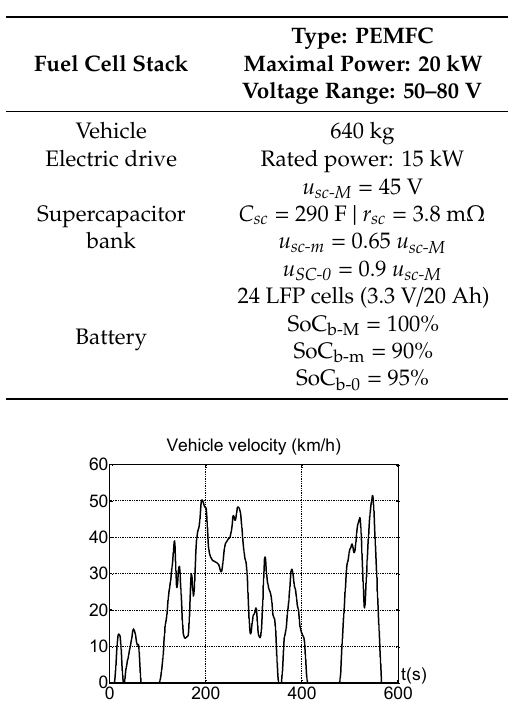
Figure 9. Standard driving cycle worldwide harmonized light-duty vehicles test cycle (WLTC) class 2 low-speed phase.